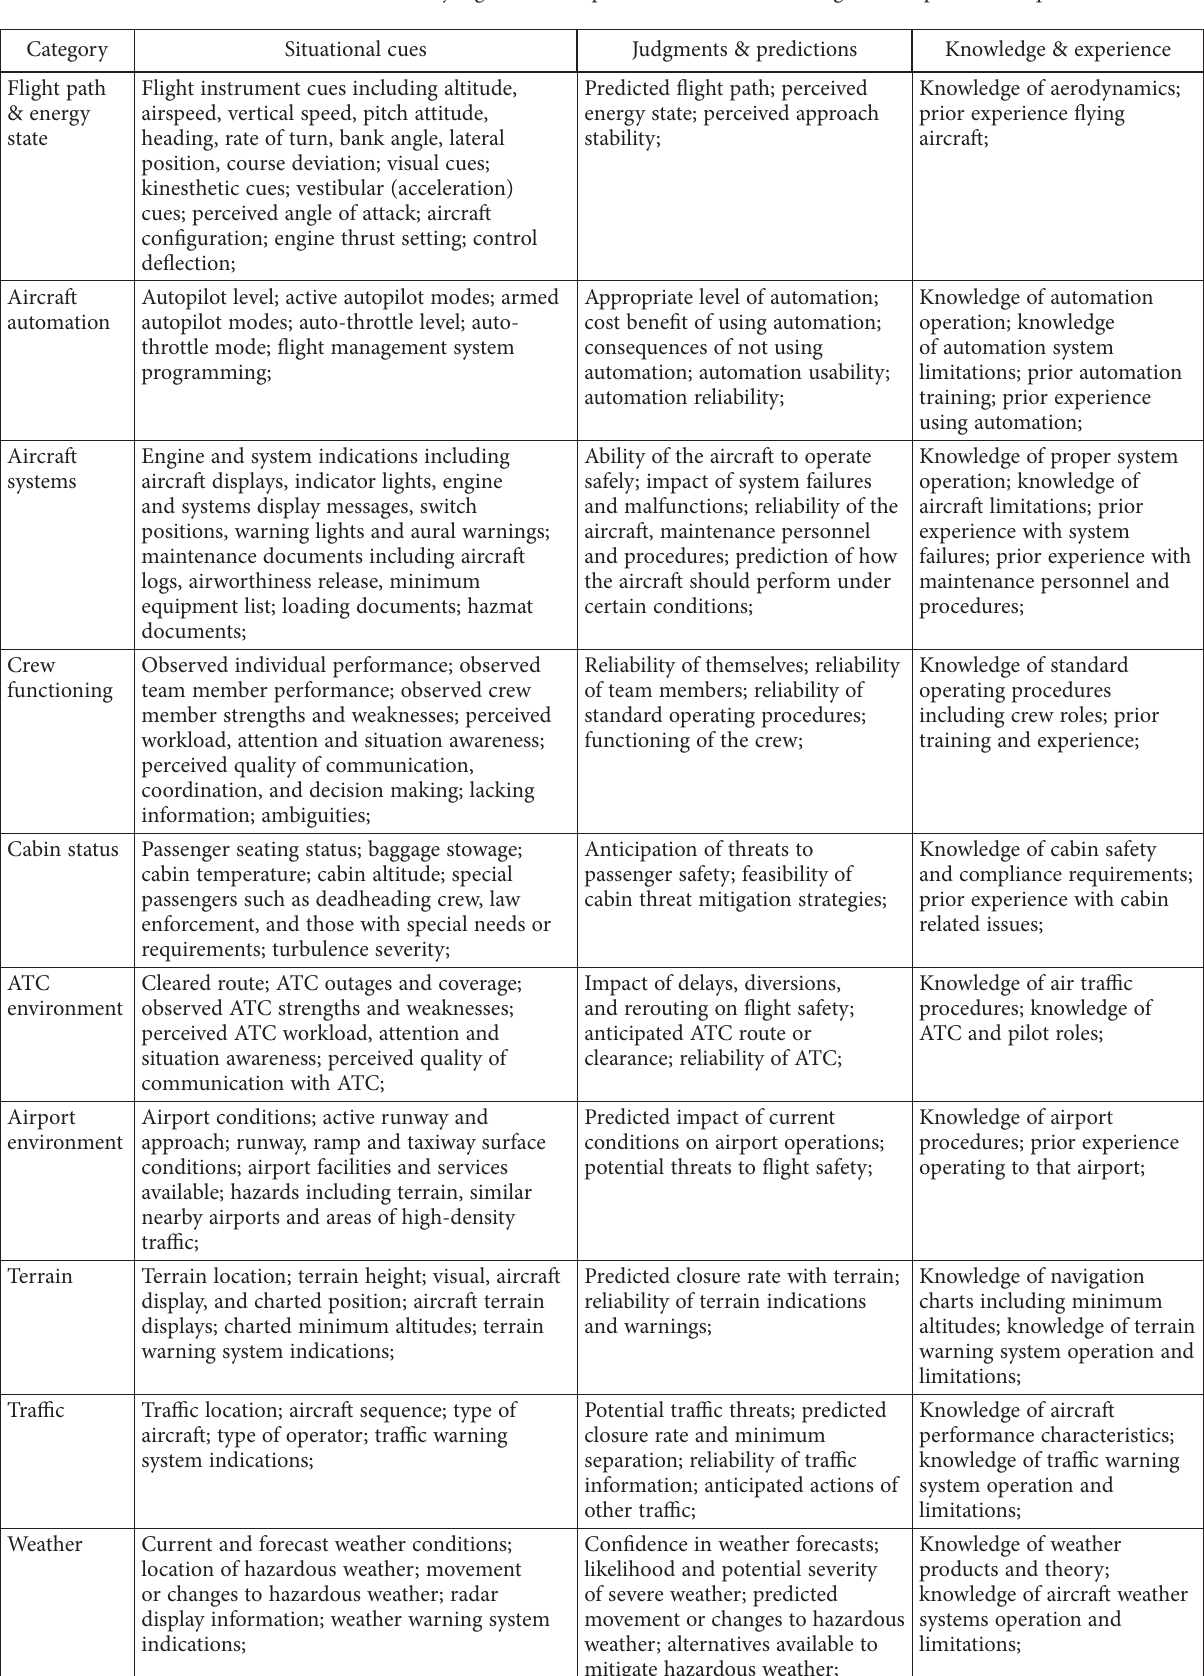
Table 2. Pilot situation awareness cues, judgments and predictions, and knowledge and experience requirements